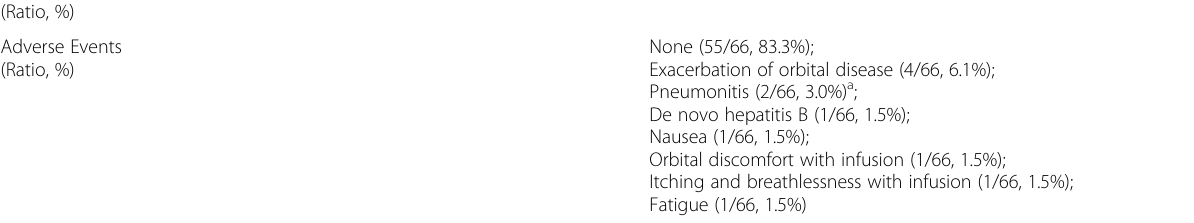
Table 1 Rituximab use in refractory non-infectious orbital inflammation - summary of comprehensive literature review (Continued) (Ratio, %) Adverse Events (Ratio, %)